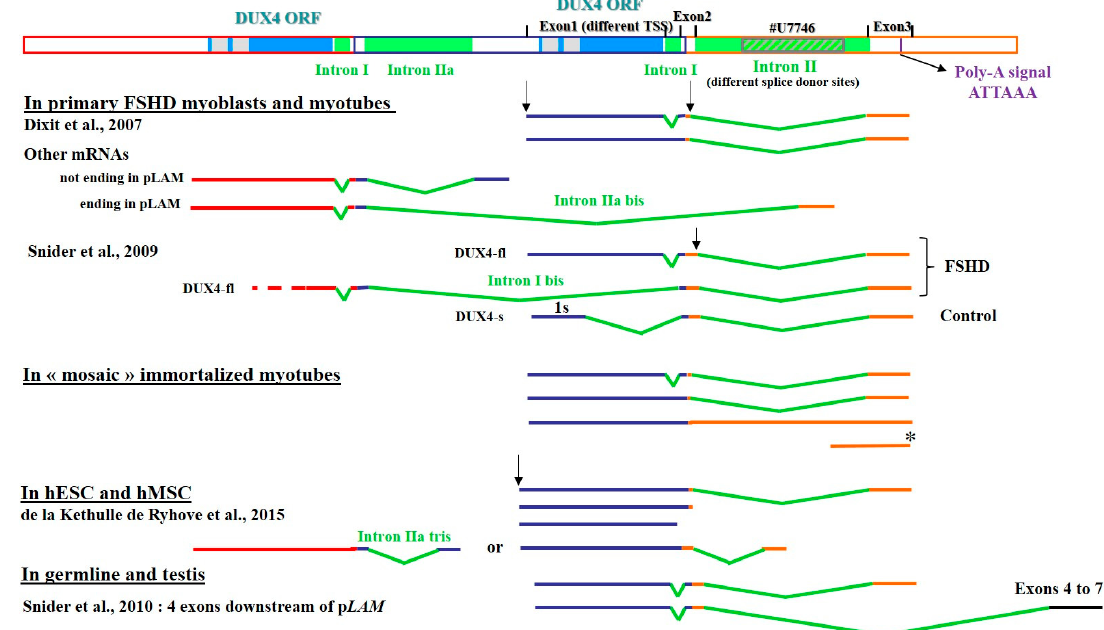
Figure 1. DUX4 mRNA variants. Schematic representation of the D4Z4 repeat array (Genbank # AF117653), the last D4Z4 unit and the adjacent pLAM region (Genbank #U7746). The DUX4 ORF is contained in the first exon. Two polyadenylation signals (PAS) were reported, one in exon 3 and one in exon 7 [19,23]. All the mRNAs reported to date or identified in our group and not published yet are represented as detected in primary FSHD myoblasts/tubes [19,22], in immortalized myotubes from clones of a mosaic individual, in human Mesenchymal Stromal cells [70] and in germline and testis [23]. We observed two different transcription start sites (TSS) and different splice donor sites for intron II. These mRNAs derived exclusively from chromosome 4. The short mRNA (*) found in FSHD immortalized myotubes is discussed in the text.